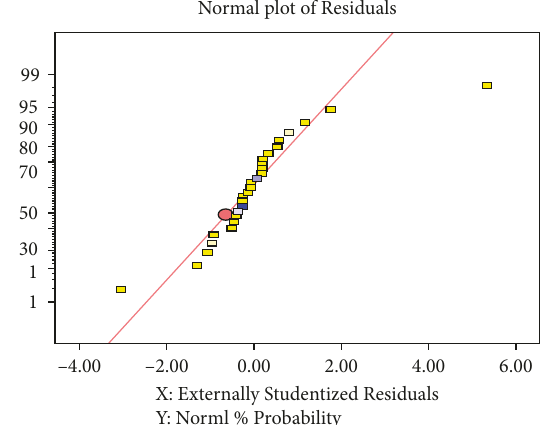
Figure 1: Normal plot of residuals of flank